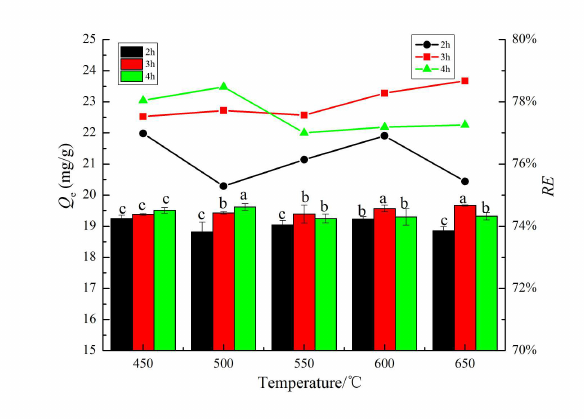
Figure 7. E ff ects of di ff erent pyrolysis process on CB adsorption capacity and removal rate for NO 3 − .